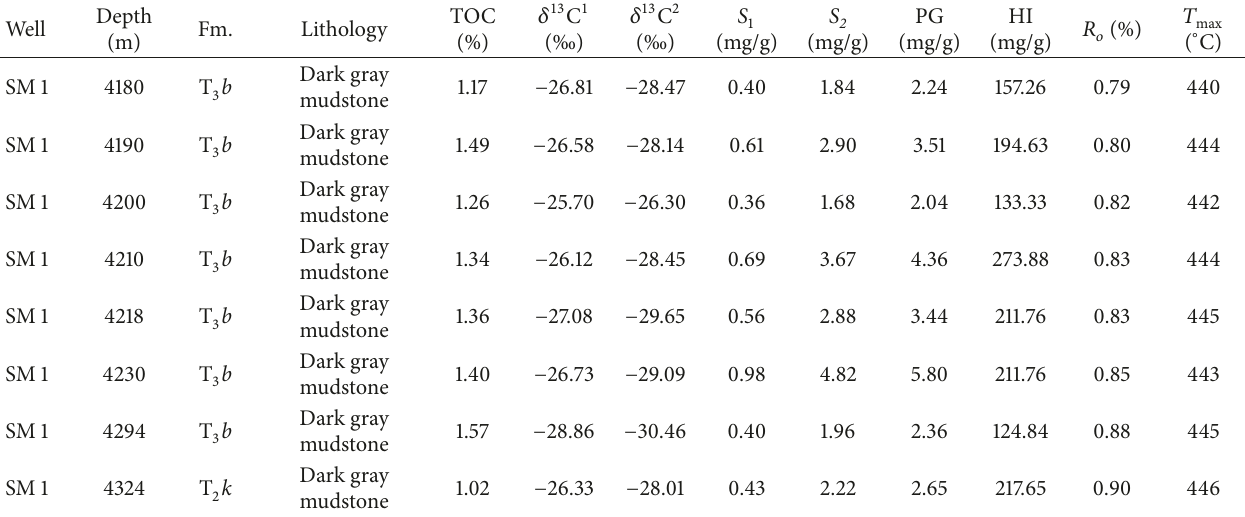
Table 1: Bulk geochemical parameters of Triassic potential mudstone source rocks in the central Junggar Basin. Depth Well